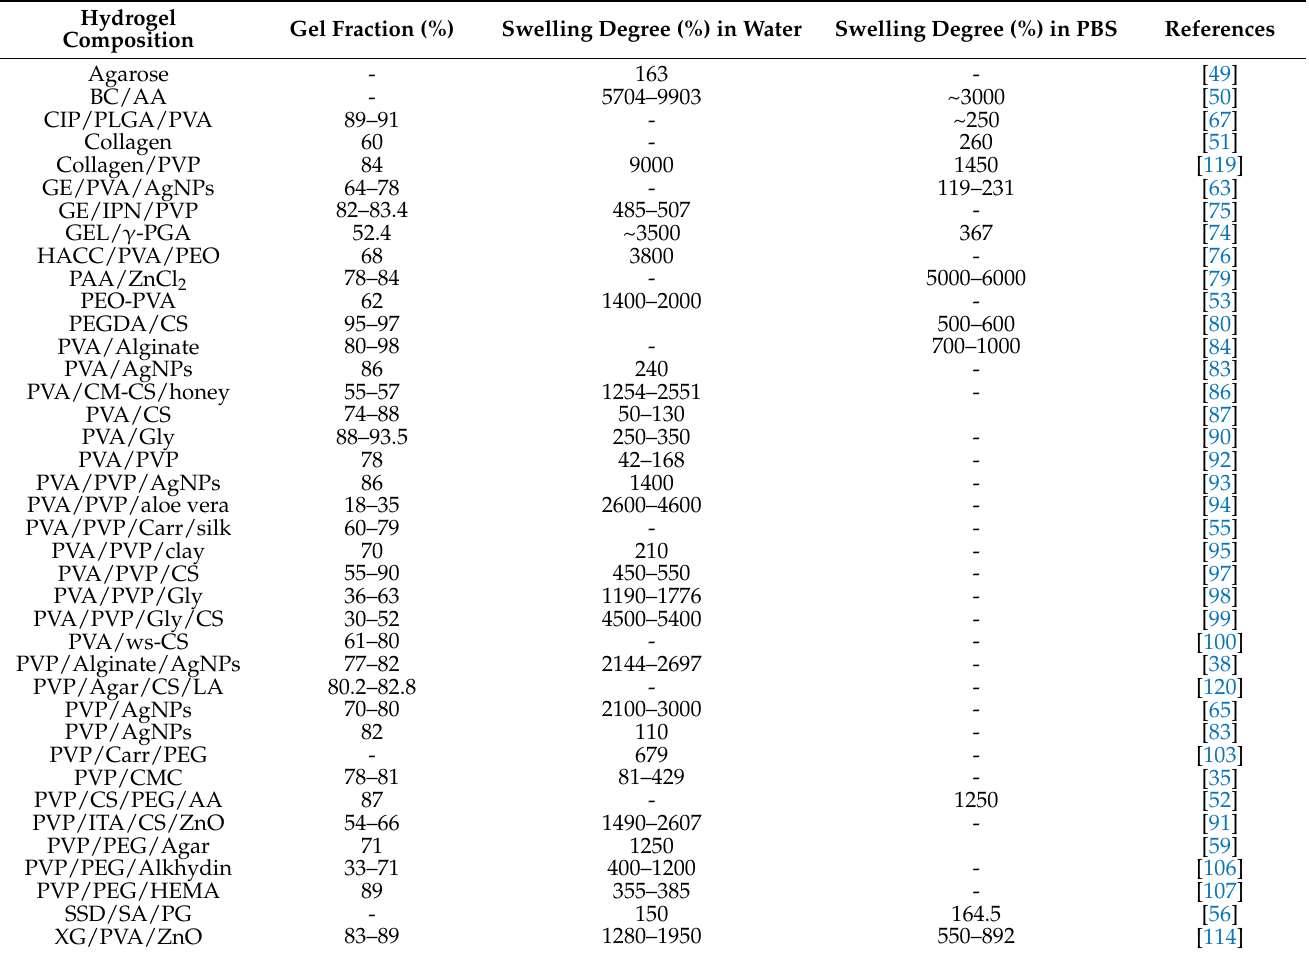
Table 2. Gel fraction, the swelling degree in water, and PBS of hydrogel wound dressings irradiated between 25–30